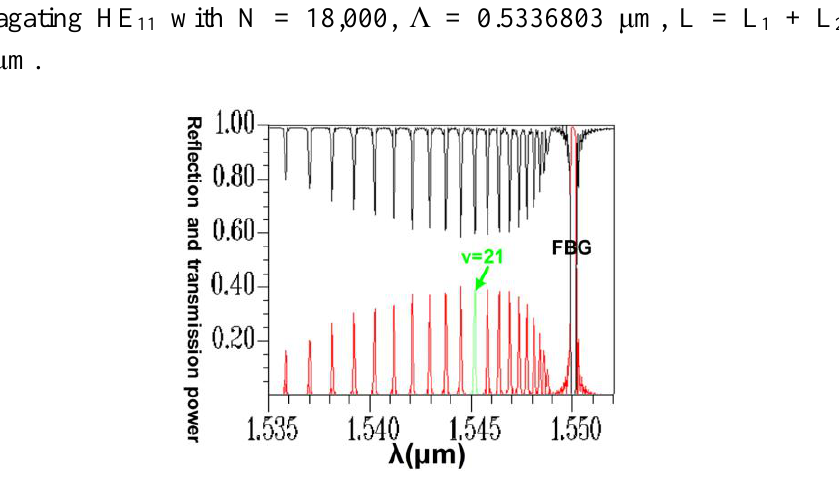
with N = 18,000, Λ = 0.5336803 μm, L = L 11